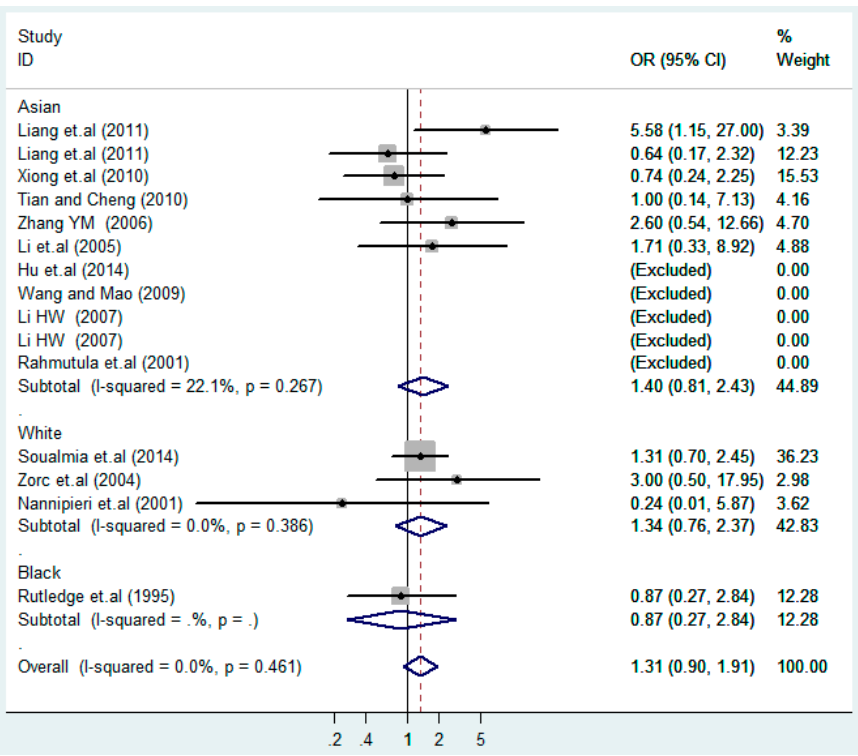
Figure 10. Ethnic subgroups analysis of T2238C co-dominant model-1 (TC vs. TT).